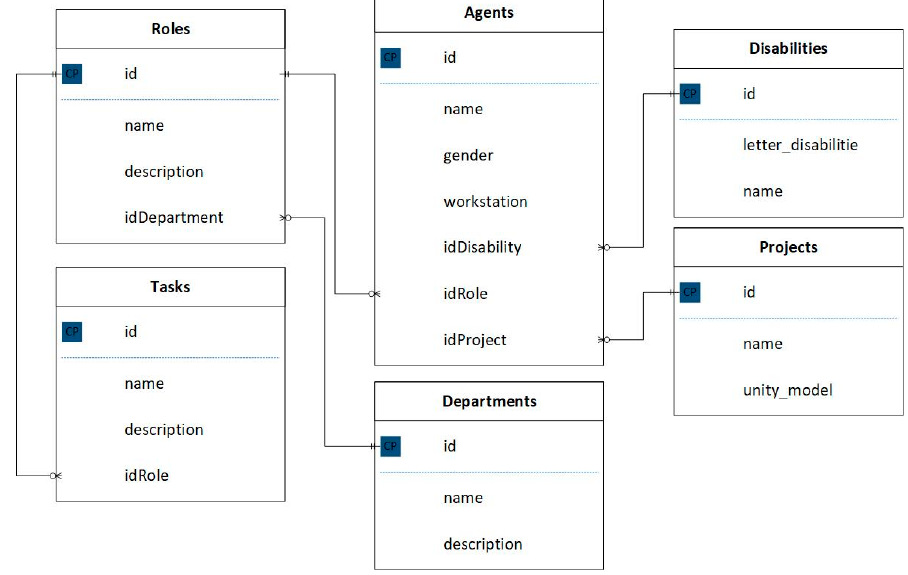
Figure 5. Virtual Organization database schema.